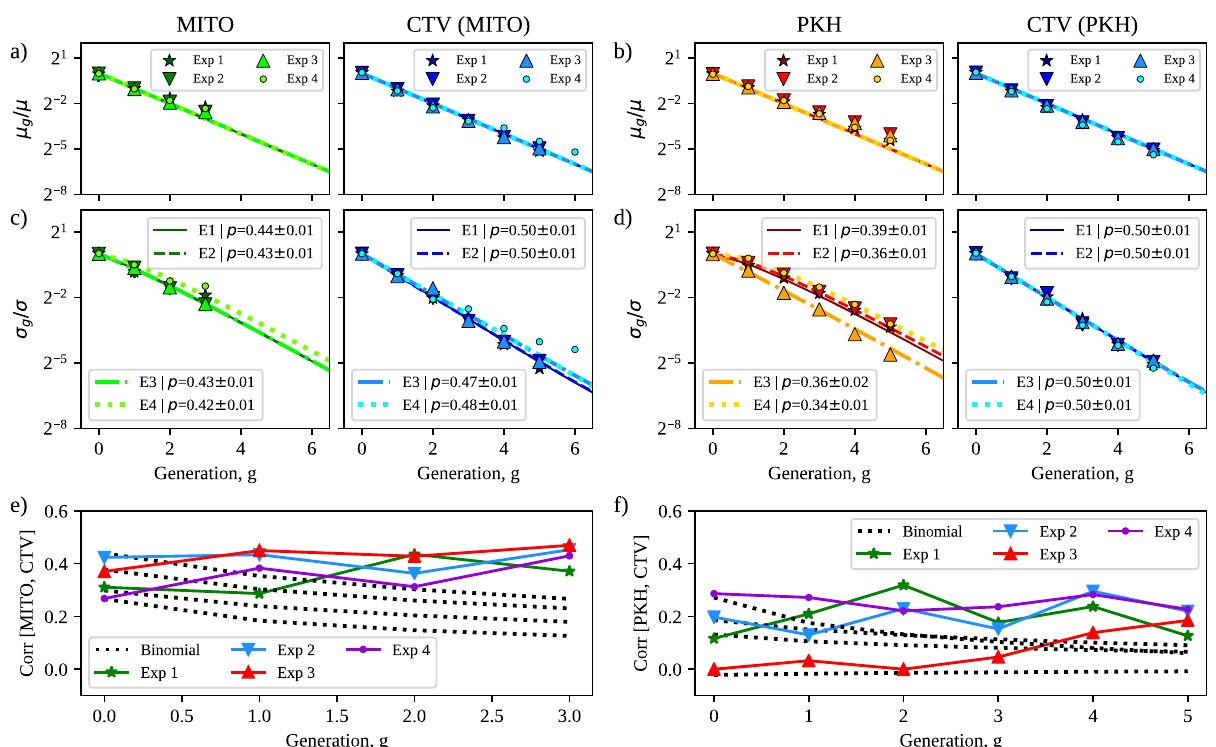
Fig. 4 Comparison between model and experiments. a , b From left to right, the mean intensity of the three markers, MITO (MitoTracker, mitochondria marker), CTV (CellTrace Violet, cytoplasm marker), and PKH (PKH Linker, membrane lipid marker) as a function of the generation, g , normalized over the mean intensity of the initial population. Different markers represent different experiments: stars, upper triangles, down triangles, and circles correspond to experiments one to four, respectively. Lines are the corresponding solutions of Eq. (17). CTV data has been analyzed twice with the Gaussian mixture method, one time associated with MITO and another with PKH. c , d Same as in ( a , b ) but with the variance of the intensity of each marker. Theoretical predictions (lines) are obtained from Eq. (19). For all experiments, the markers correspond to the mean of the values for each generation, while the sizes of the markers are comparable with the standard errors of the mean. e Pearson correlation between the intensities of MITO and CTV markers as a function of the generations. The gray dotted line represents the predictions of an uncorrelated binomial partitioning, starting with a correlated initial population. f Same as in ( c ) but with the correlation between PKH and CTV